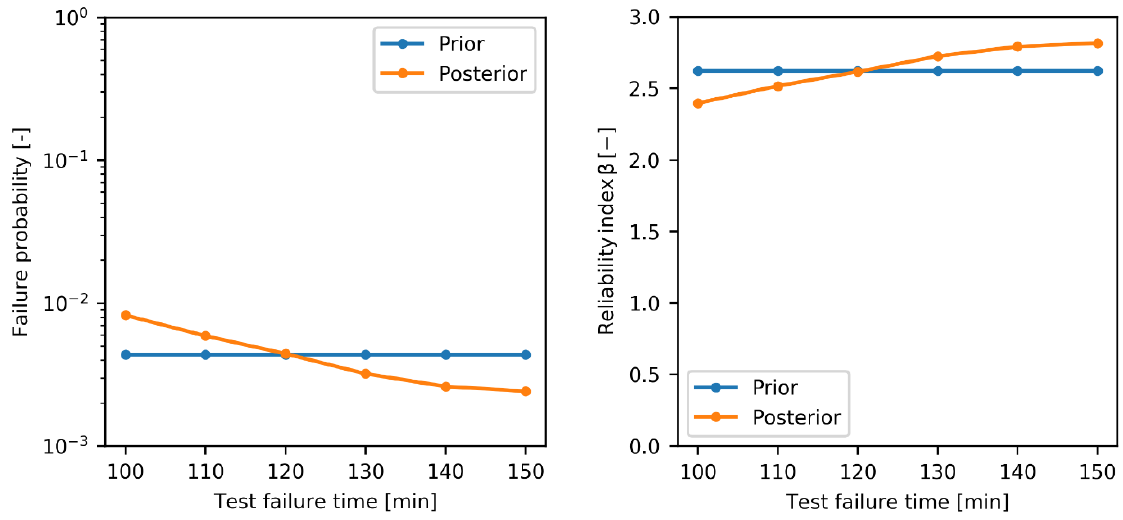
Figure 4. Failure probability (left) and reliability index (right) in the function of the failure